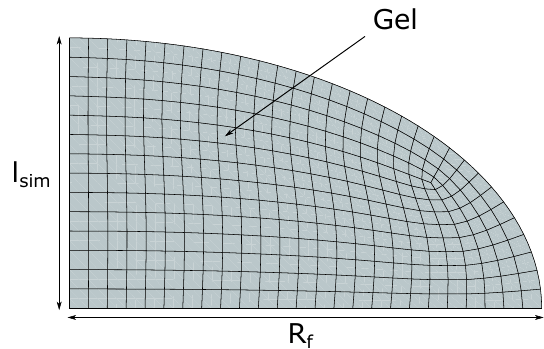
Figure 8. Axisymmetric finite element model of a hemi-ellipsoid hydrogel. The vertical edge of length l sim is the axis of symmetry. The horizontal edge of length R f is bounded to the optical fiber (see Figure